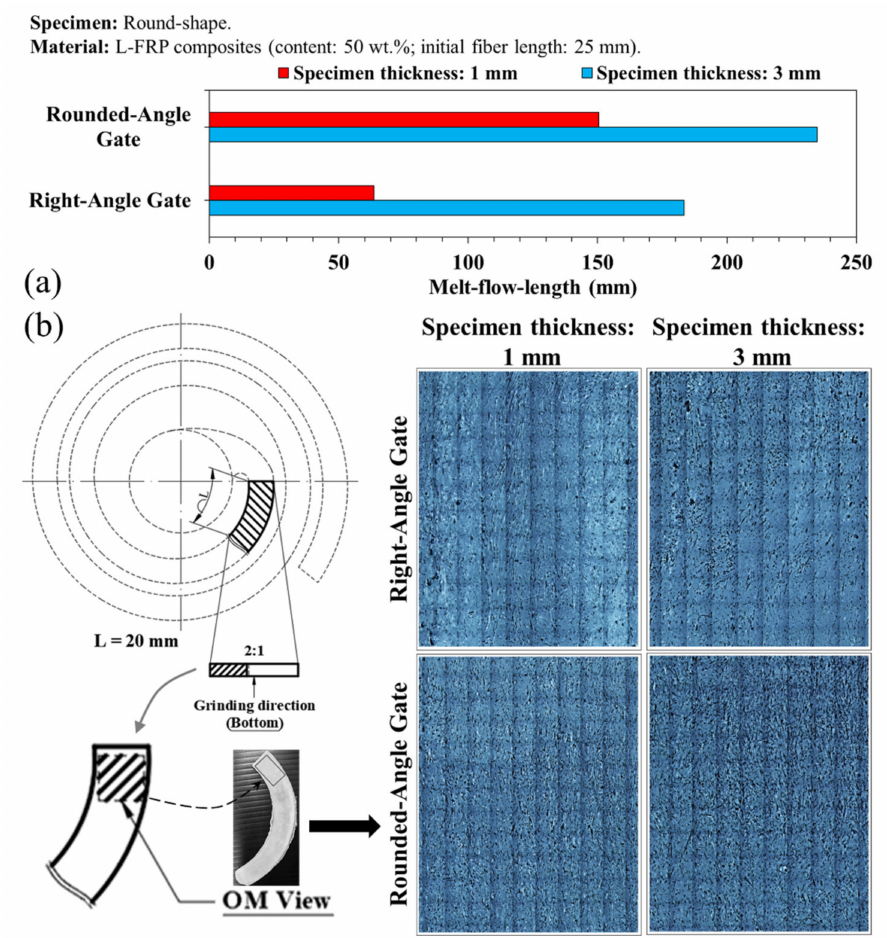
Figure 6. ( a ) Variations of melt flow length with different gate design and specimen thickness. ( b ) Optical scanning and observation of the fiber flow and orientation on the